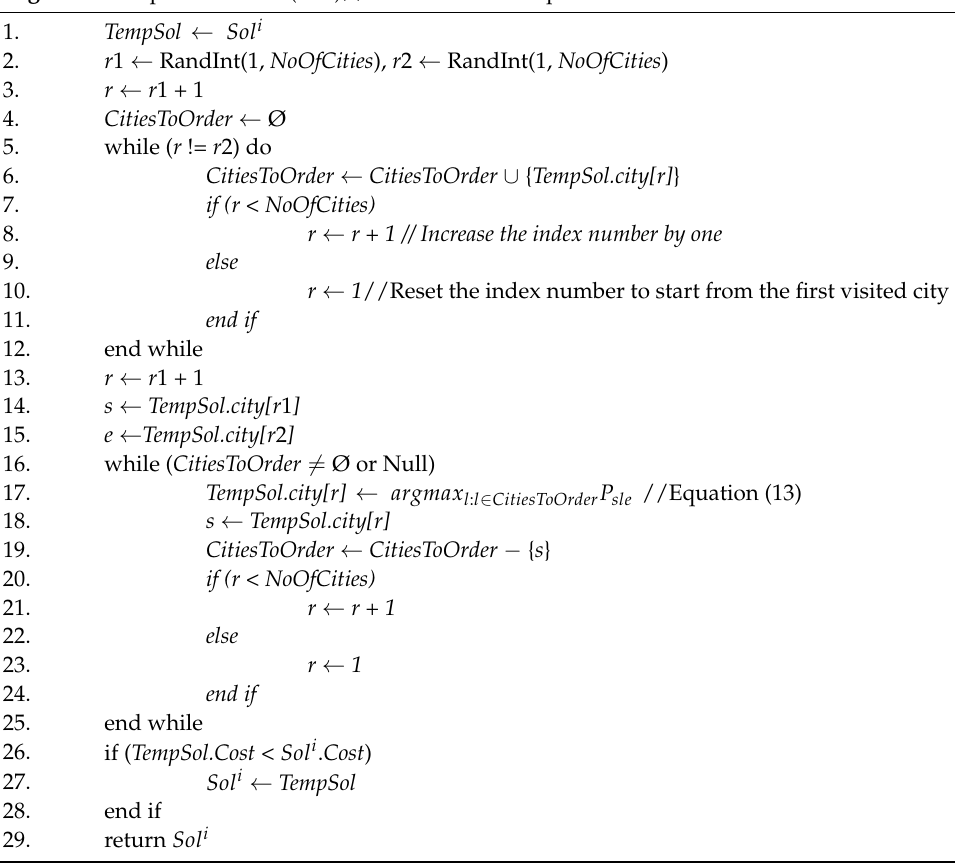
Algorithm 2 UpdateSolution( 𝑆𝑜𝑙 (cid:3036) )//Partial Solution Update